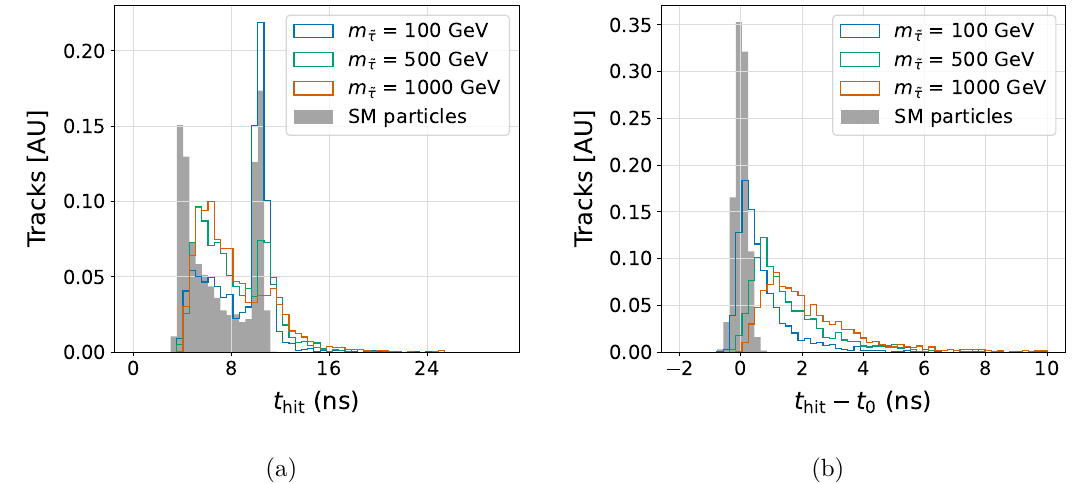
Figure 18. Timestamp as measured by the time-of-flight detector (a) and delay in time of arrival with respect to particles travelling at the speed of light (b). These distributions incorporate a realistic spread in collision time and z position, as well as the timing layer’s temporal resolution. SM particles with p 10 GeV from the signal samples are shown for T >